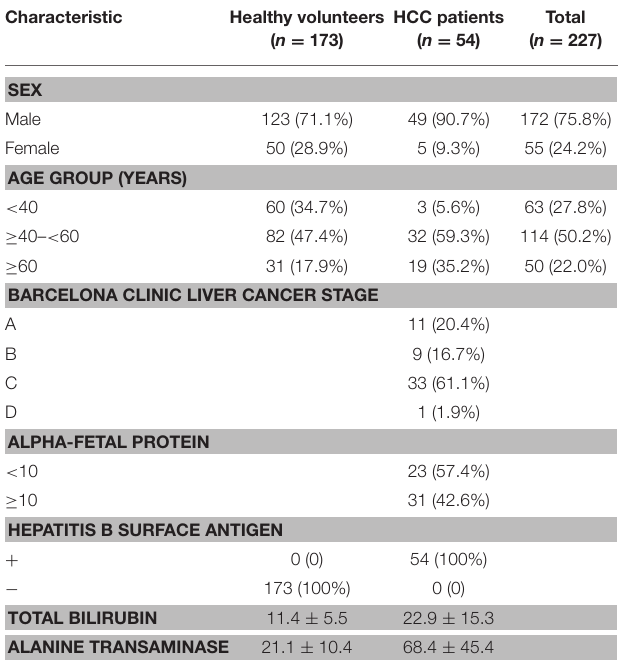
Supplementary Table 3 . The extraction recoveries and matrix